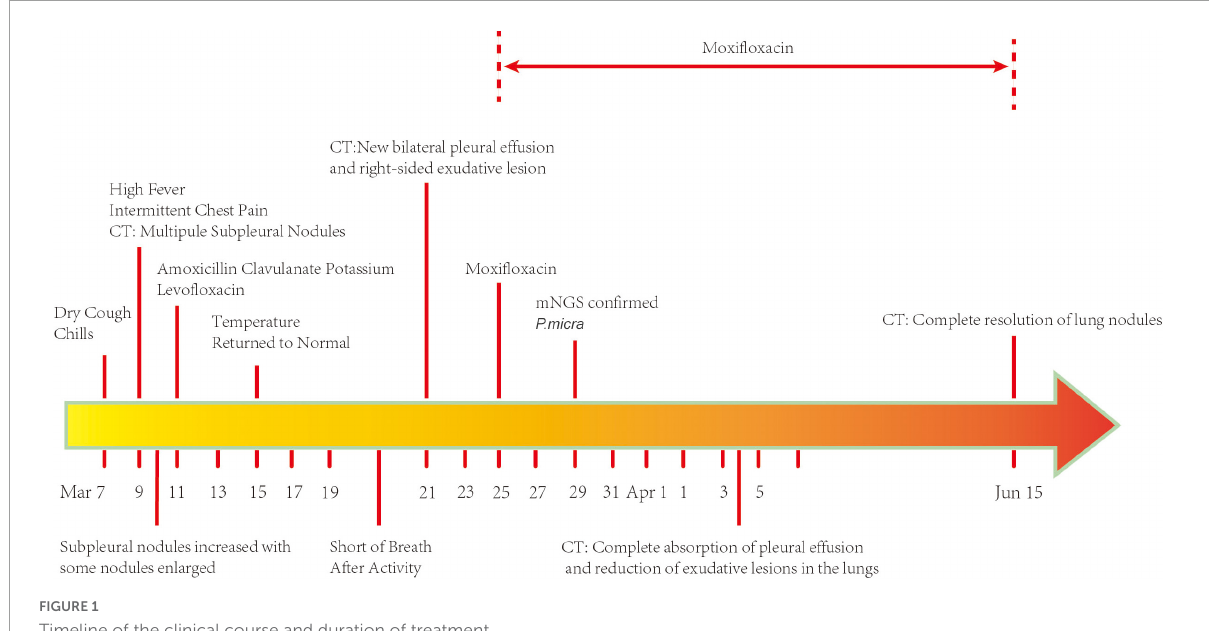
in normal tap water that was not changed every day.